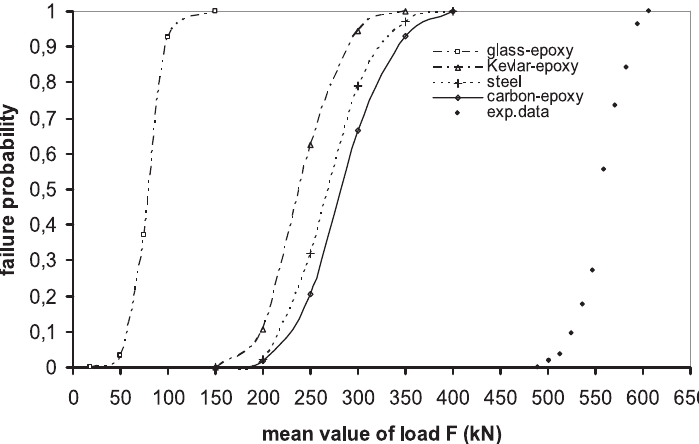
Fig. 7. Failure probability according to axial load F ( q = 0